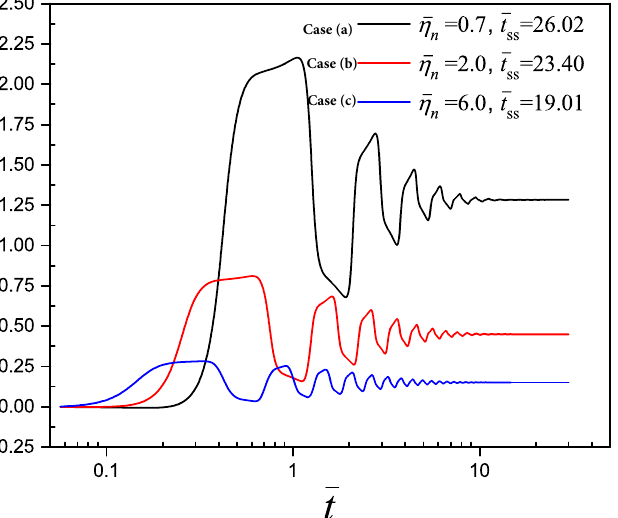
Figure 8. Velocity tracking of an electro-osmotic flow, cases taken from Figure 5. Case ( a ) ¯ η n = 0.7, Case ( b ) ¯ η n = 2.0, and Case ( c ) ¯ η n = 6.0 at the middle of the